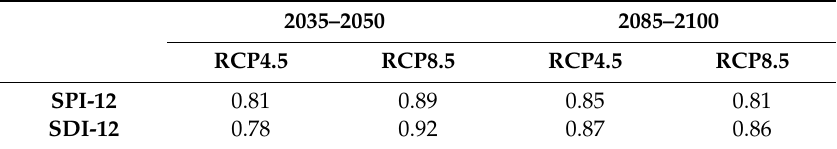
Table 4. Values of correlation coe ffi cients between annual TWYDs and the